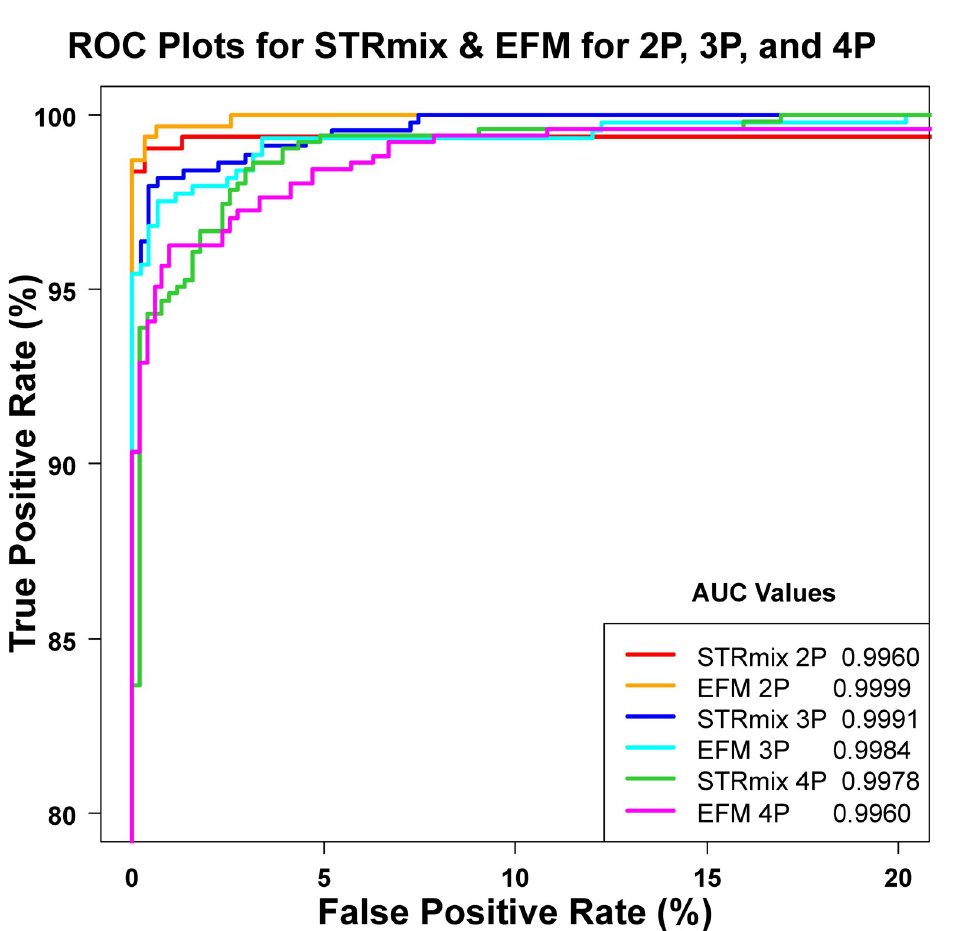
Fig 4. Empirical ROC plots used to study discrimination performance of the LR systems. ROC plots are built per varying NOC and software. Each NOC dataset is composed of profiles of different DNA quality, quantity, and mixture proportions. The red, blue, and green curves are the ROC plots constructed using LR values of known contributors and known non-contributors of 2P, 3P, and 4P mixtures analyzed within STRmix, respectively. ROC plots constructed with LR values assigned by EFM are shown in orange (2P), cyan (3P), and magenta (4P). The plot contains a total of 308 H1-true tests and 308 H2-true tests for the 2P analysis, 441 H1-true and 441 H2-true calculations for the 3P analysis, and 508 H1-true and 508 H2-true tests for the 4P mixtures. The calculated AUCs and p-values are shown. All p-values were > 0.05.